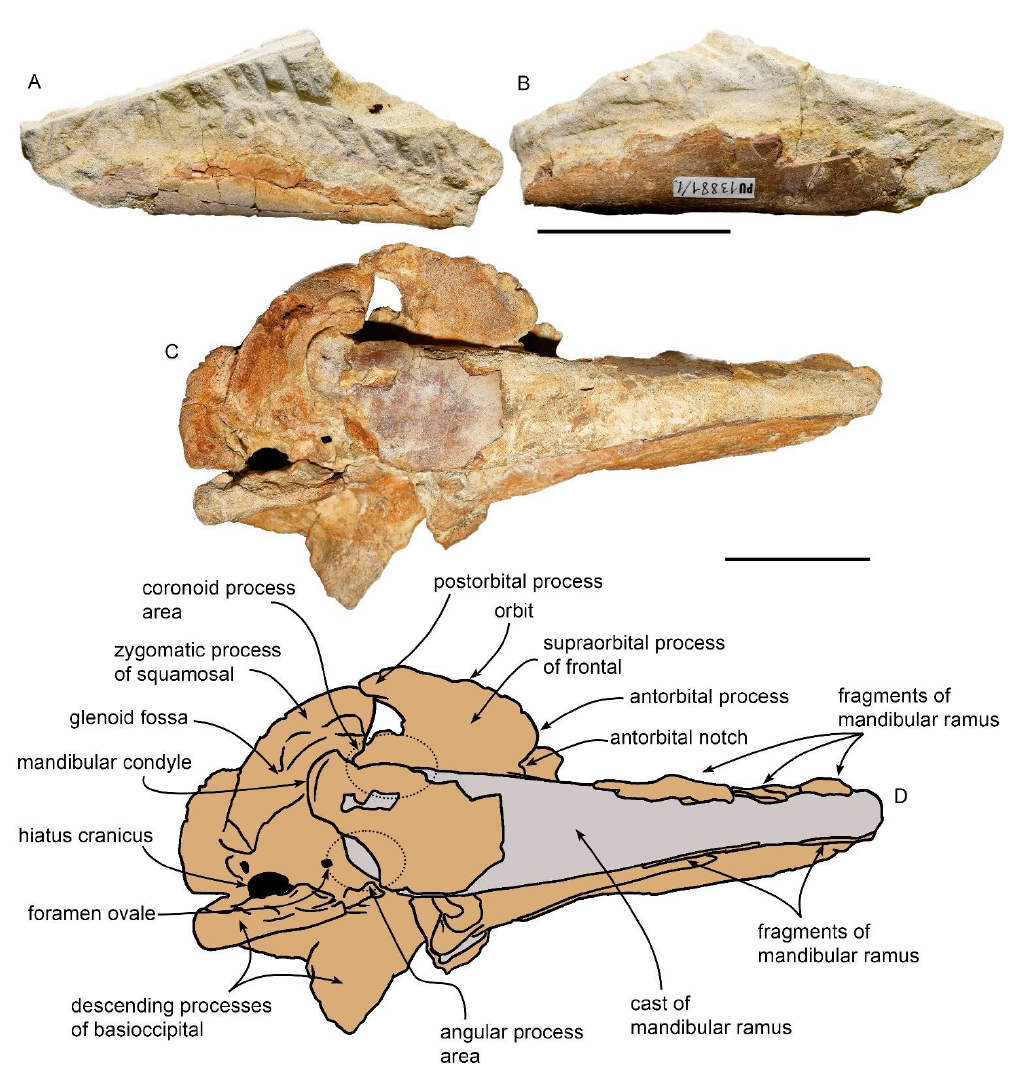
Figure 6. Mandibular morphology of MGPT-PU 13881/1. ( A ) Separated mandibular fragment belonging to the partial skull MGPT-PU 13881 in lateral view. ( B ) The same in medial view. ( C ) Photographic representation of the skull MGPT-PU 13881 in right ventrolateral view showing the right dentary orthogonally to its anteroposterior axis. ( D ) Anatomical interpretation of ( C ). Scale bar equals 5 cm.